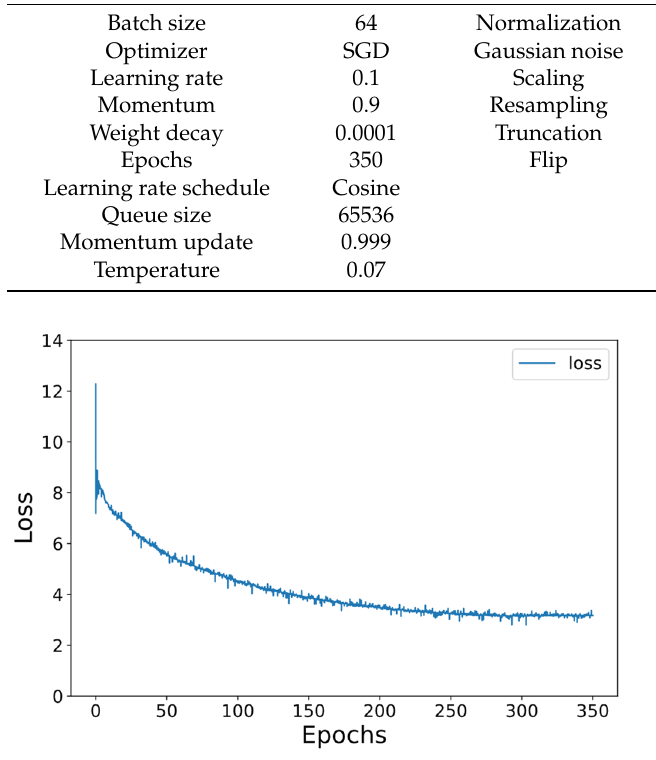
Figure 7. Loss history of self-supervised on unlabeled dataset